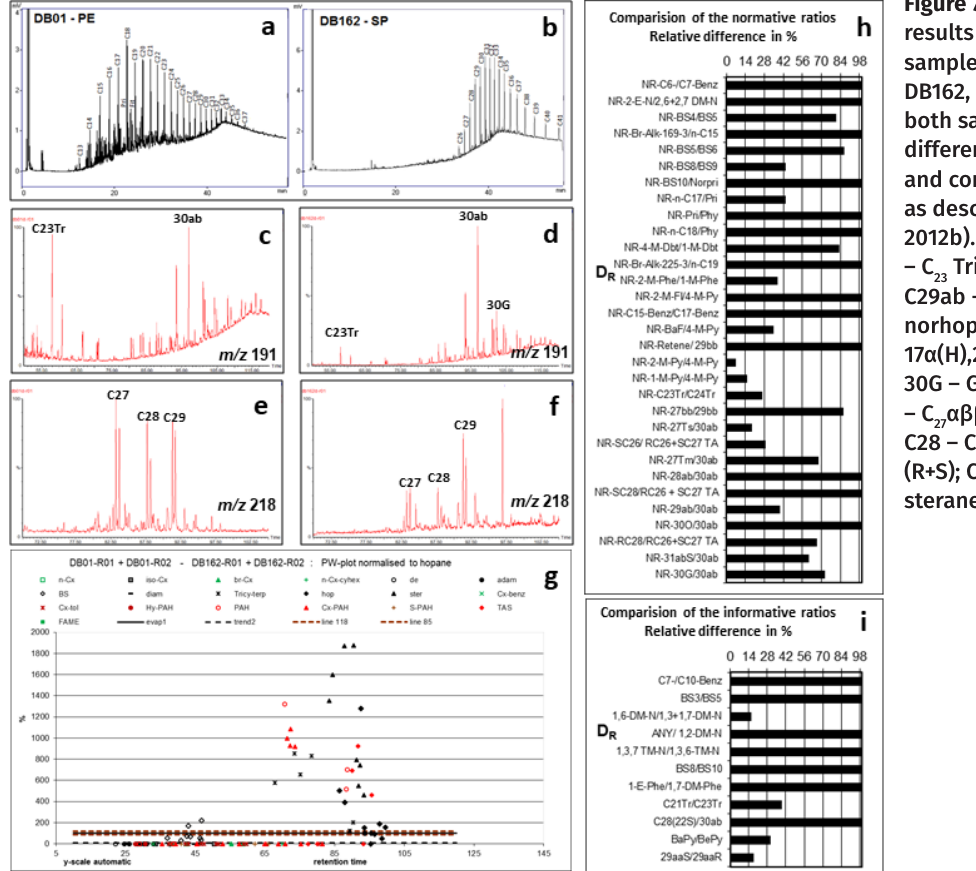
Figure 7. Combined results between samples DB01 and DB162, indicating that both samples are from different sources (DRs and compound